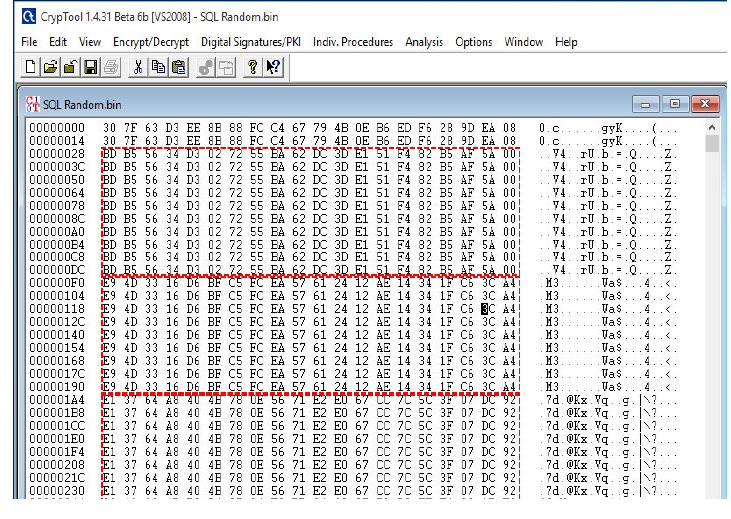
Fig. 4. SQL random